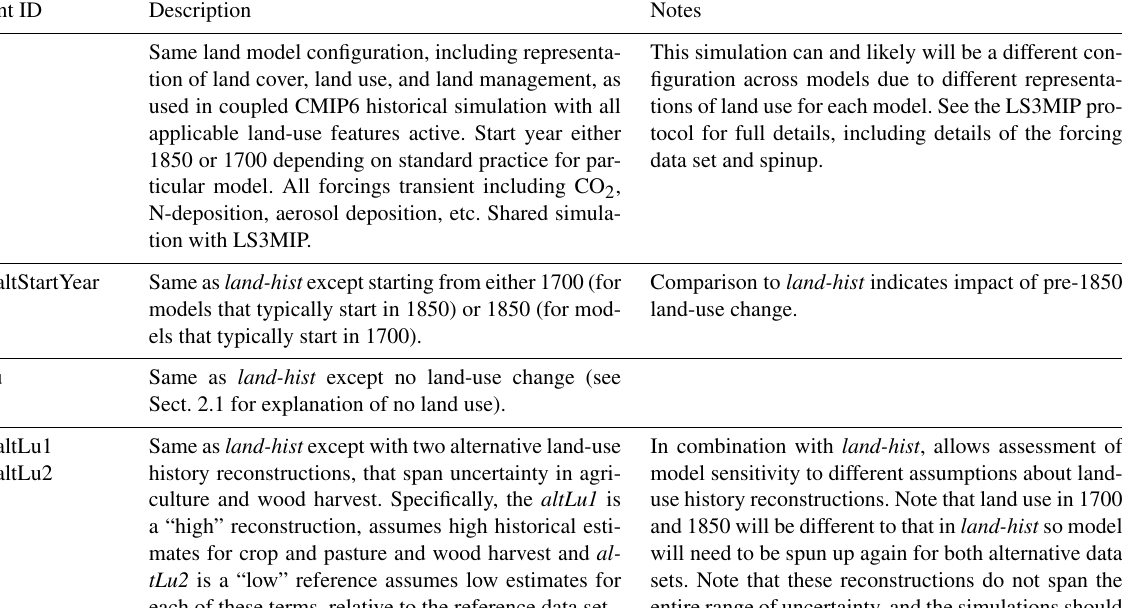
Table 2. Land-only land-cover, land-use, and land-management change simulations. Assess relative impact of land-cover, land-use, and land-management change on fluxes of water, energy, and carbon; forced with historical observed climate. The simulations land-hist , land- hist-altStartYear and land-noLu are Tier 1, all other simulations are Tier 2. All simulations should be pre-industrial to 2015, where the pre-industrial start can be either 1850 or 1700, depending on the